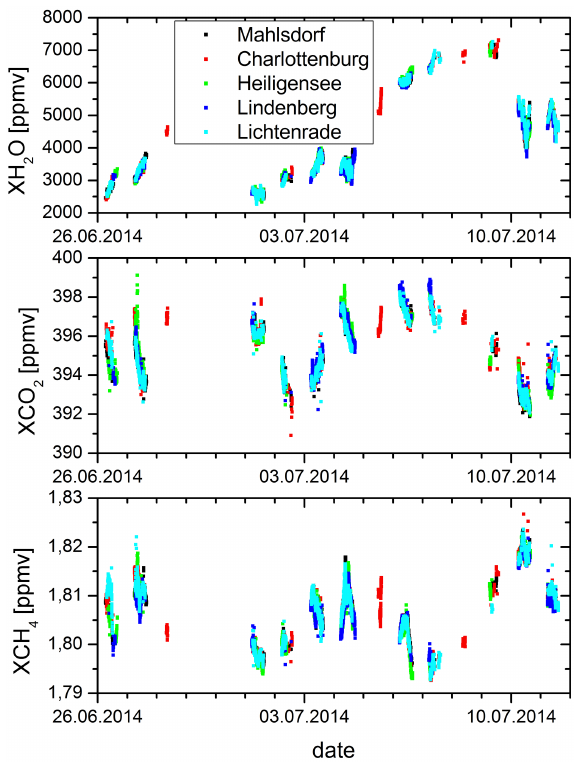
Figure 4. Evolution of XH 2 O (top panel), CXO 2 (middle panel), and XCH 4 (bottom panel) as measured at all sites during the cam-